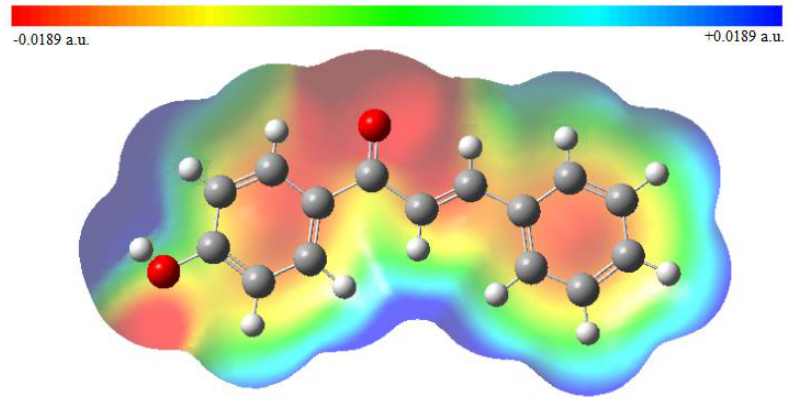
Figure 5. Molecular electrostatic potential surface for the studied molecule.